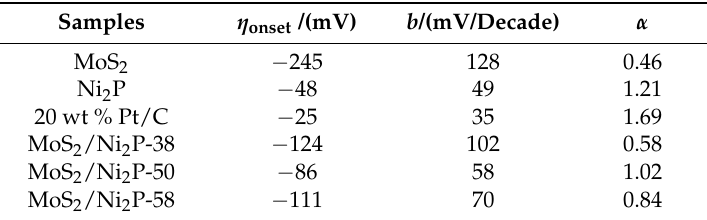
Table 2. The obtained values of onset overpotentials ( η onset ), Tafel slope ( b ), and charge transfer coefficient ( α